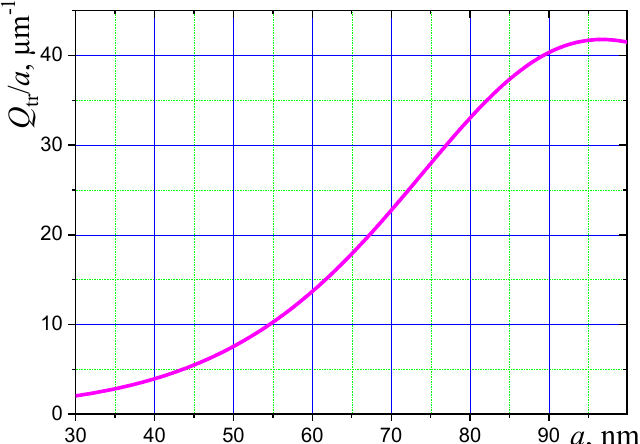
Figure 7. The calculated ratio of transport efficiency factor of extinction to the radius of copper particle at wavelength 𝜆 = 660 nm.